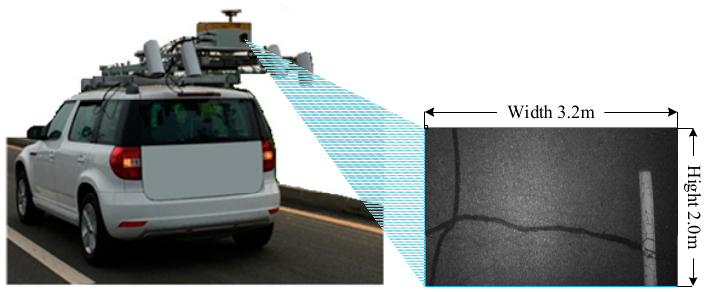
Figure 2. Mobile pavement distress detection equipment. The vehicle was equipped with an acA4096 array camera and two hernia lamps to reduce the in fl uence of light intensity. The image resolution was 3517 × 2193 pixels, and the single pixel size was 0.91 × 0.91 mm. was 3517 × 2193 pixels, and the single pixel size was 0.91 × 0.91